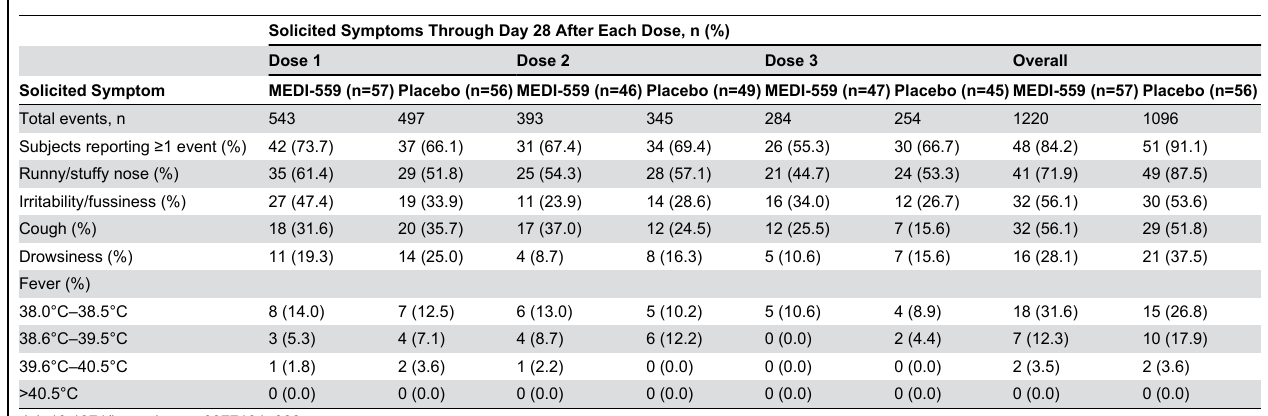
Table 2. Solicited symptoms through day 28 after each dose.